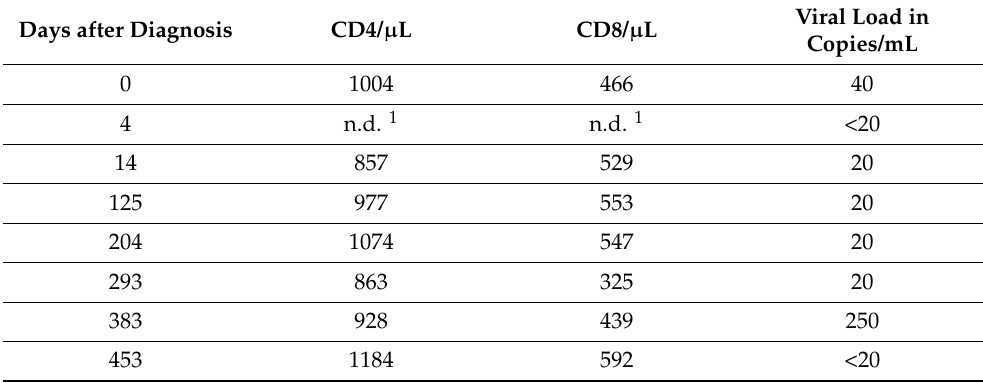
Table 1. Immunological and virological parameters in controller